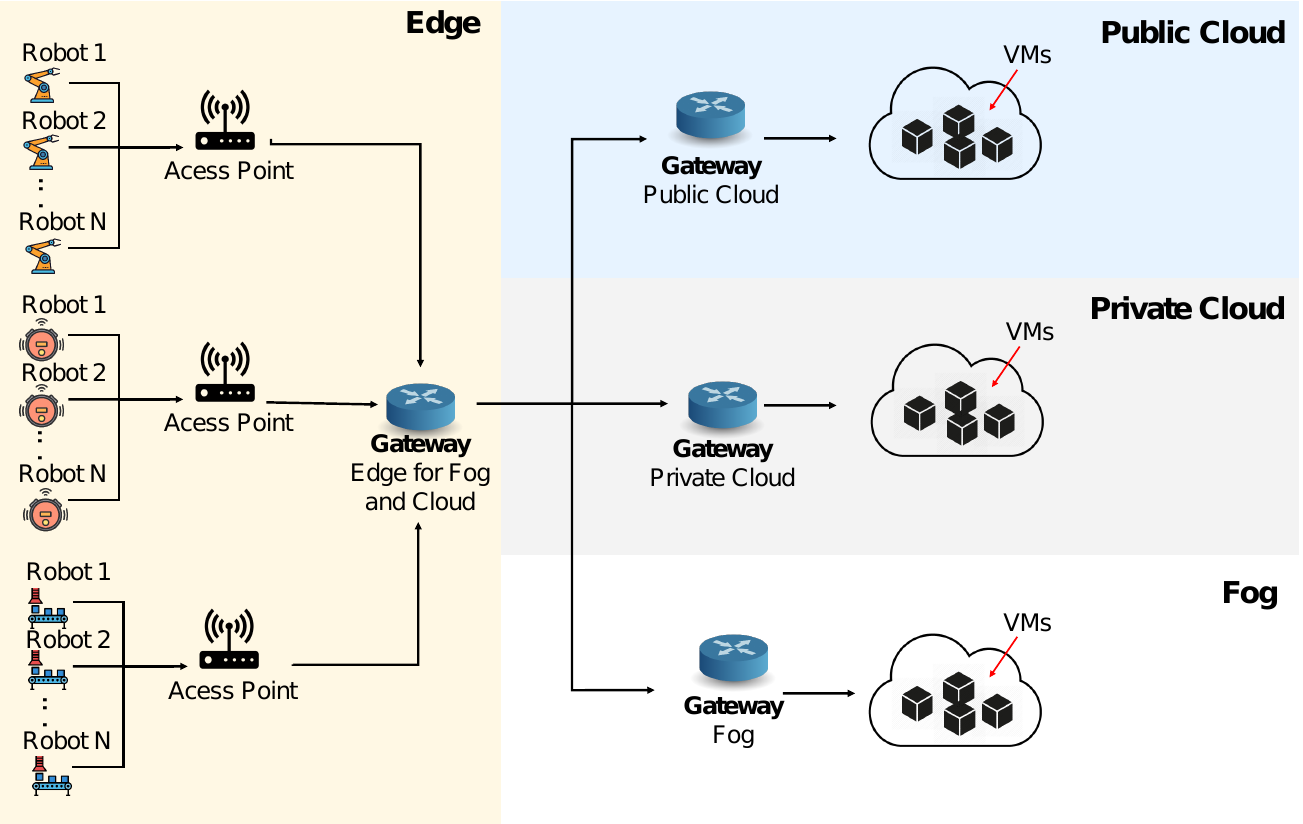
Figure 2. Illustration of the architecture of an IoRT system supported by remote computing